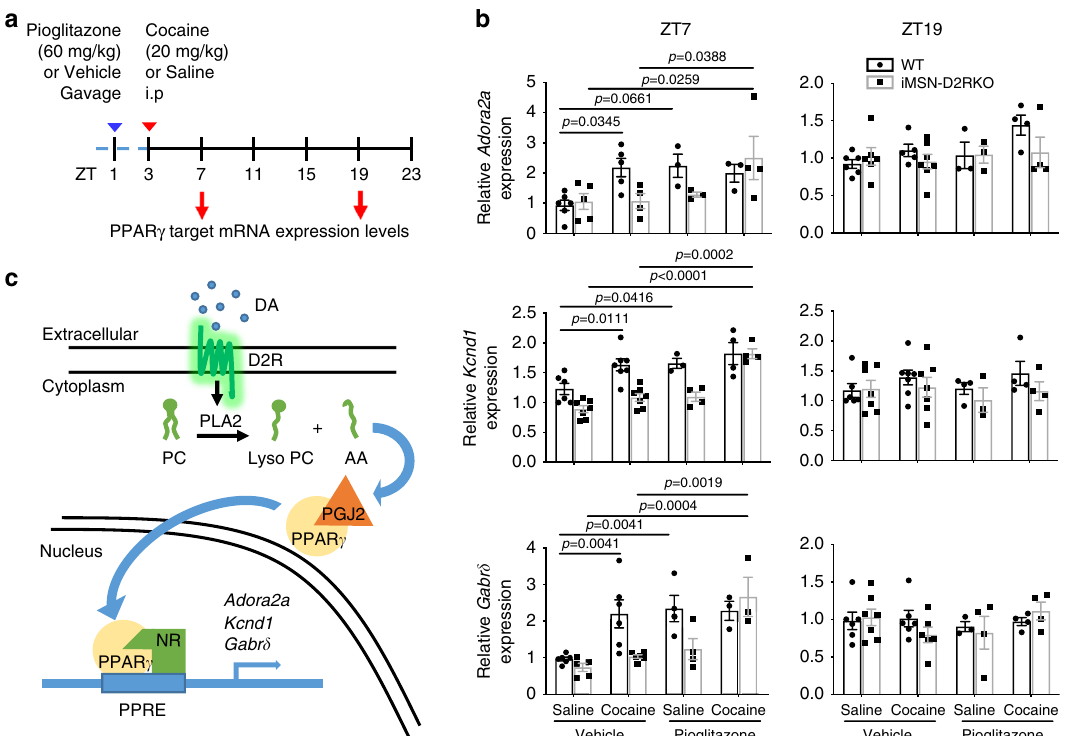
Fig. 7 Pharmacological activation of PPAR γ restores PPAR γ signaling iMSN-D2RKO mice. a Schematic representation of the experimental design, arrowheads indicate the time and treatment of Pioglitazone (blue) and Cocaine treatments (red). b Expression of selected PPAR γ target genes Adora2a, Kcnd1 , and Gabr δ as determined by quantitative real time PCR at ZT7 and ZT19 in presence or absence of Pioglitazone (60 mg kg − 1 ) prior to saline or cocaine (20 mg kg − 1 ) ( Adora2a ZT7: Genotype: F (1, 25) = 2.003, p = 0.1693; Treatment: F (3, 25) = 4.682, p = 0.0099; Interaction: F (3, 25) = 2.479, p = 0.0845 (Vehicle and Saline: WT n = 6, iMSN-D2RKO n = 5; Vehicle and Cocaine: WT n = 5, iMSN-D2RKO n = 4; Pioglitazone and Saline: WT n =